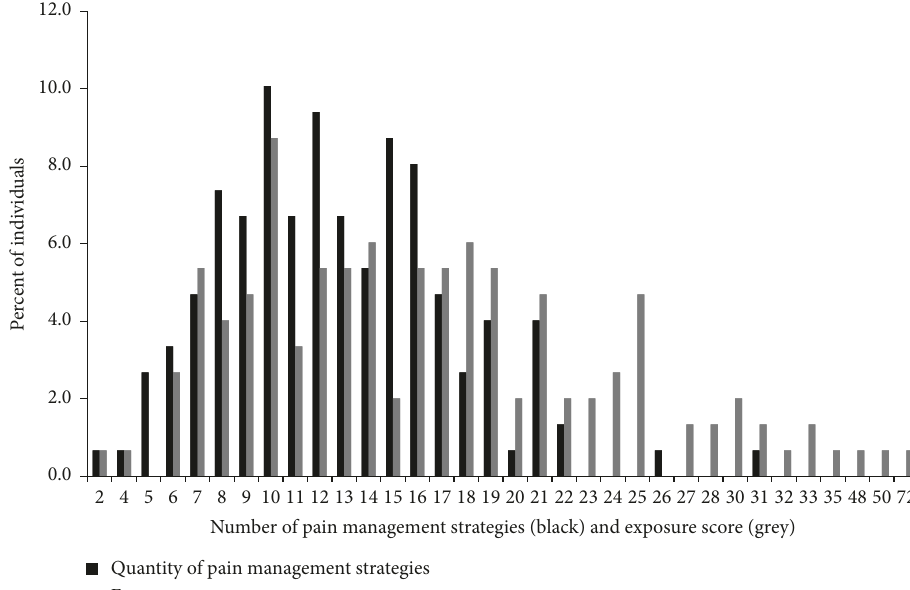
Figure 1: Percent of individuals using each number of pain self-management strategies and percent of individuals assigned each exposure score. The black bars indicate the number of pain management strategies used. The grey bars indicate the exposure score. For example, Figure 1 shows 10.1% of individuals used 10 pain management strategies and 8.7% of individuals had an exposure score of 10, while 0.7% of individuals used 20 pain management strategies and 2% of individuals had an exposure score of 20. Mean number of strategies used (standard deviation 4.6). Mean exposure score 16.8 (standard deviation 9.1). (cid:31) (cid:31) (cid:31)